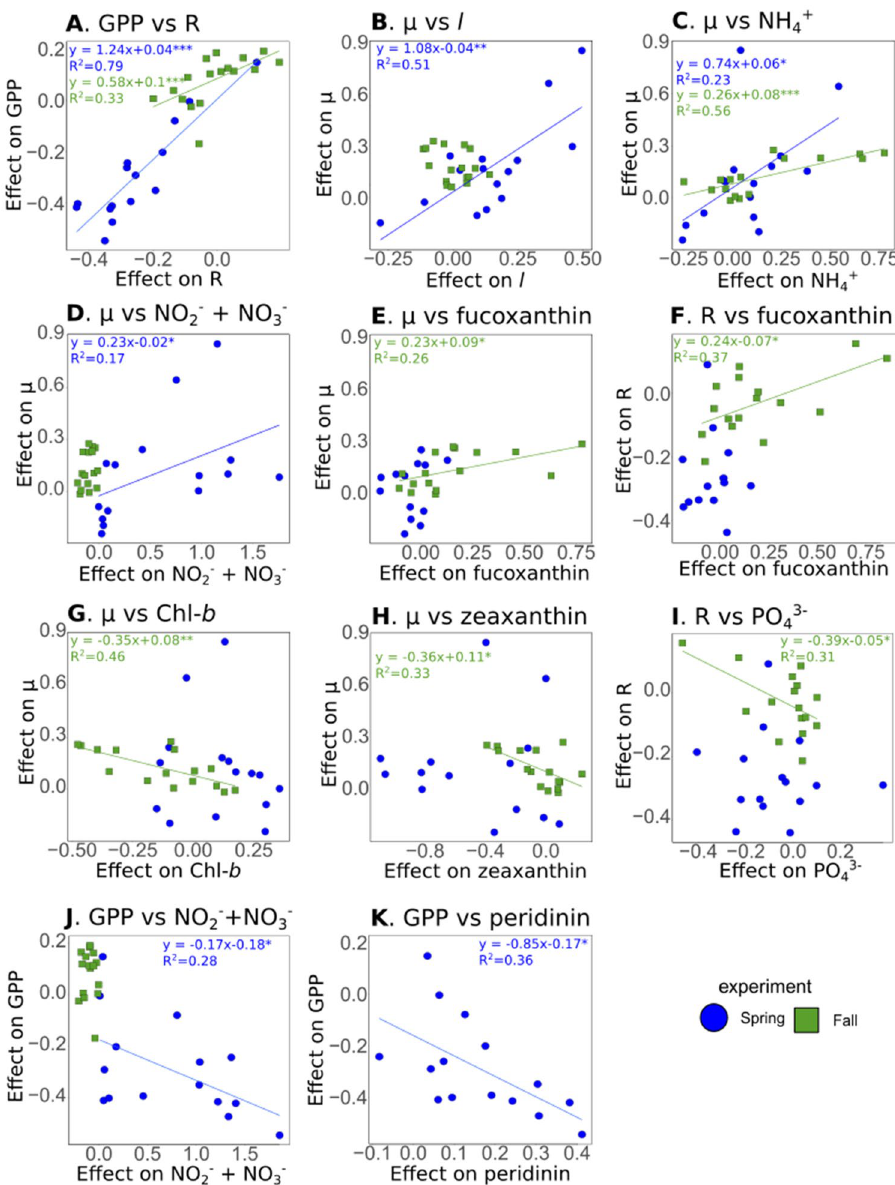
Figure 6. Linear relationships between the effect of warming on plankton processes, environment variables and pigment concentrations. Ordinary least squares linear relationships between the effect of warming, expressed as the log response ratio, on GPP, R, µ, and l , and the effect of warming on environmental and pigment variables for the spring (blue circles) and fall (green squares) experiments. Relationships were individually assessed for each experiment. Only statistically significant relationships ( p < 0.05) are represented and solid blue lines represent the linear least square fit for the spring experiment while solid green lines represent the linear least square fit for the fall experiment. ( A ) Gross Primary Production (GPP) vs Respiration (R), ( B ) growth rate (µ) vs loss rate ( l ), ( C ) µ vs NH 4+ , ( D ) µ vs NO 2− + NO 3− , ( E ) µ vs fucoxanthin, ( F ) R vs fucoxanthin, ( G ) µ vs chlorophyll- b (Chl- b ), ( H ) µ vs zeaxanthin, ( I ) R vs PO 43− , ( J ) GPP vs NO 2− + NO 3− , ( K ) GPP vs